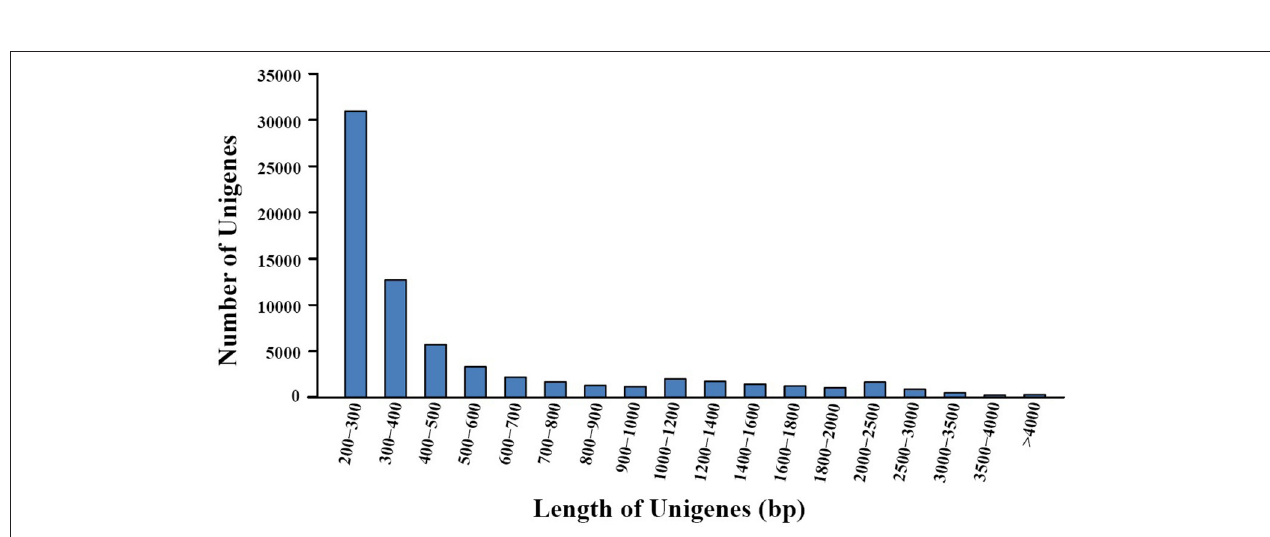
FIGURE 2 | Distribution of unigene lengths resulting from de novo transcriptome assembly of fruits from Actinidia eriantha.